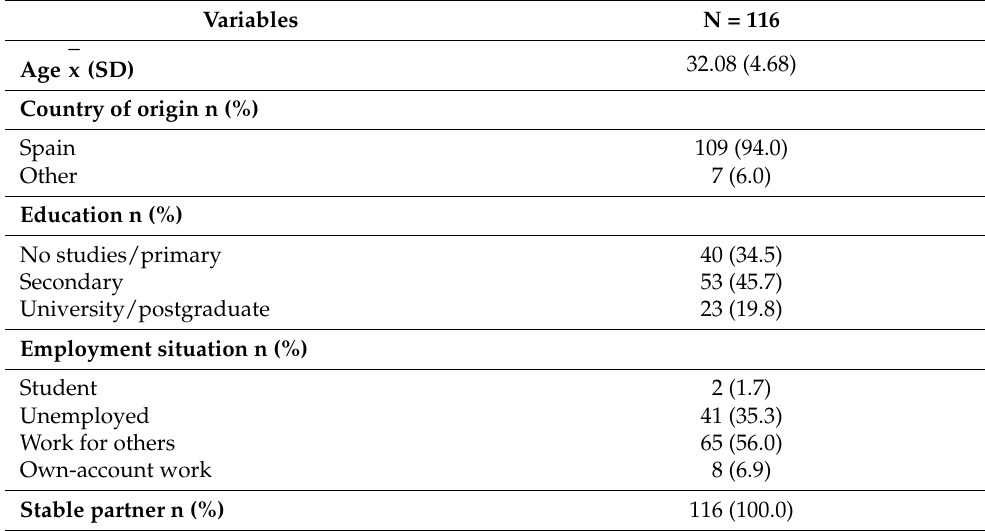
Table 1. Sociodemographic characteristics of the